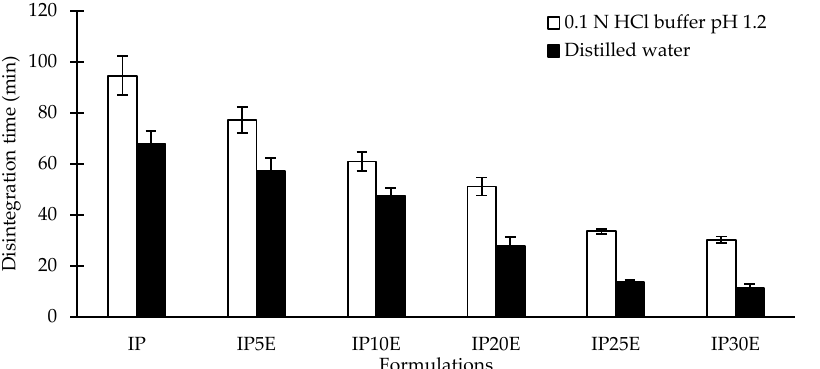
Figure 6. In vitro disintegration of eutectic effervescent tablets in distilled water and 0.1 N HCl buffer pH 1.2 .